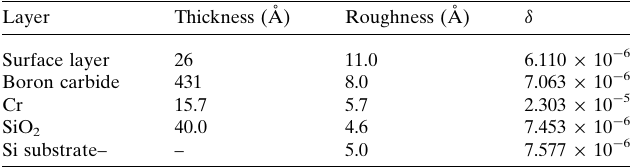
Table 1 GIXRR fit parameters of boron carbide/Cr as-deposited